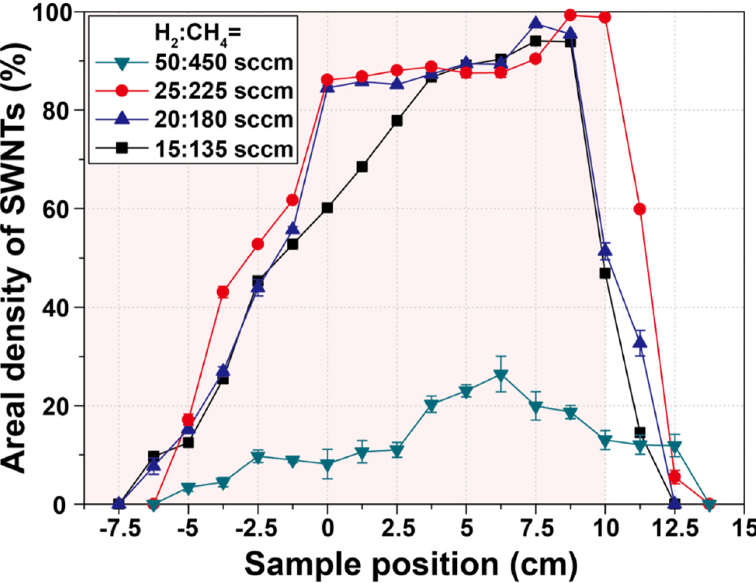
Figure 3. Variation of the areal density of SWNTs with respect to gas flow rate and sample position.